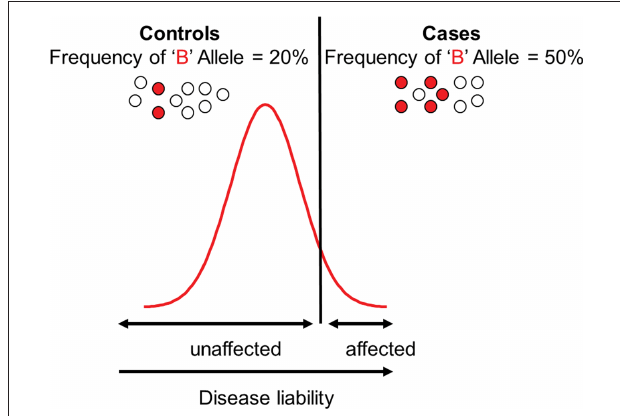
Figure 1 | Allele frequency differences between cases and controls as defined by the liability threshold model. The white circles refer to the null allele, and the red circles refer to the risk (‘B’) allele. The cases are above the threshold for disease on the liability distribution and are more likely to carry the risk allele than the